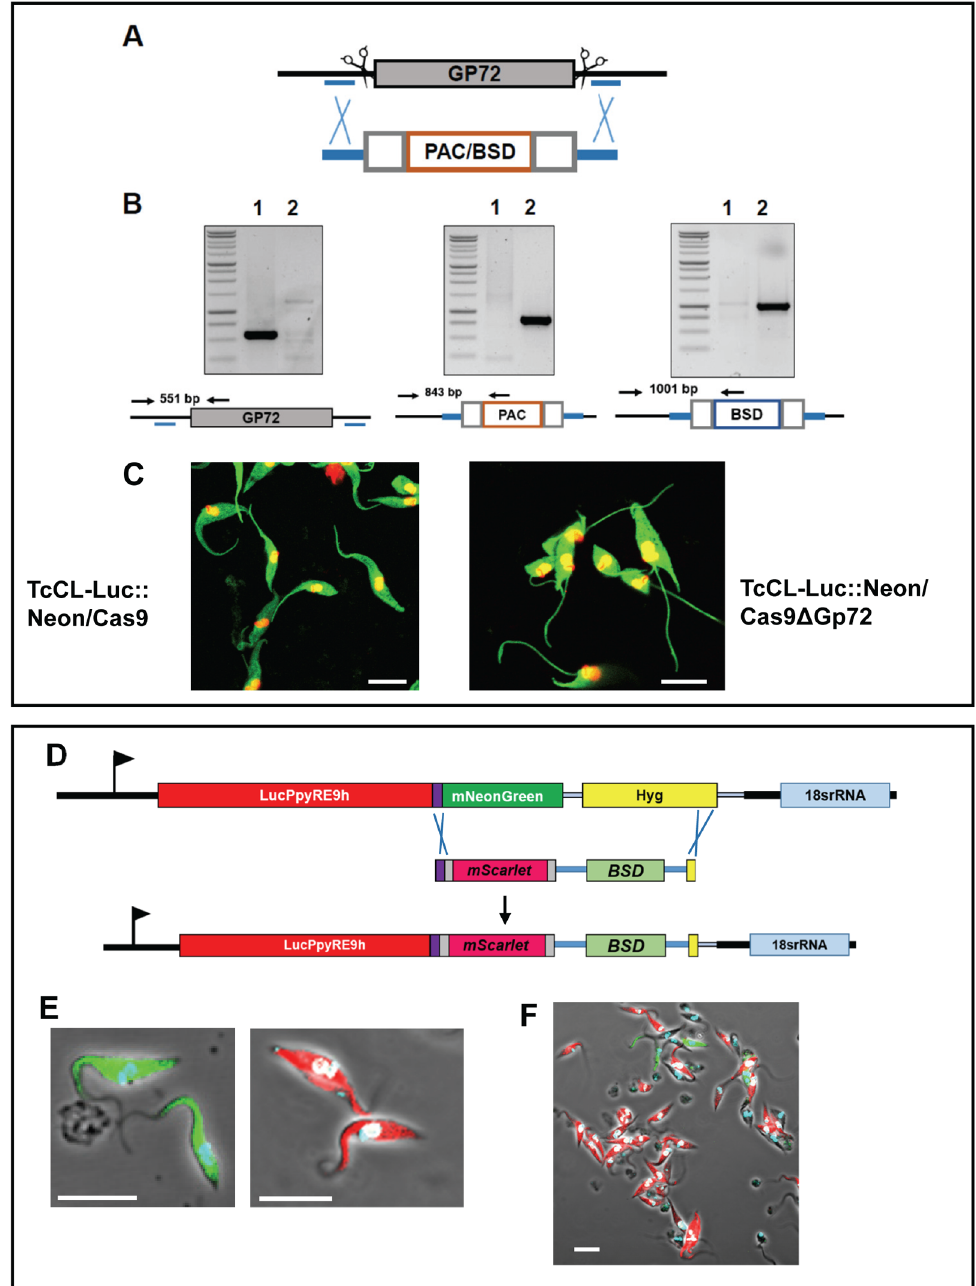
Fig 7. CRISPR/Cas9 mediated genome editing in the T . cruzi CL-Luc::Neon reporter strain. A. Diagram of the GP72 gene indicating sgRNA binding sites (indicated by scissors) and homology arms for integration (blue bars). The lower map shows the configuration of the puromycin (PAC) and blasticidin (BSD) drug resistance cassettes. Grey boxes indicate plasmid derived RNA processing signals; orange box shows the coding sequence for the selectable marker. B. PCR-based confirmation of gene deletion (Methods). Lane 1, parental clone, Lane 2, a null mutant clone. The relative positions of the primers are illustrated on the maps below each panel. The GP72 gene is only present in the parental clone and both selectable markers have integrated as expected. C. The GP72 null mutant parasites are characterised by detachment of the flagellum from the cell body. Left hand panel, the parental strain (TcCL-LNCas9); right hand panel, the GP72 null mutant. Note that the flagellum in the null mutants exits the cell immediately anterior to the kinetoplast, whereas in the parental strain it remains attached along the length of the cell body. D. Strategy for CRISPR-Cas9 mediated replacement of mNeonGreen by mScarlet. The map of the Luc::Neon locus indicates the Cas9/sgRNA mediated cleavage sites.